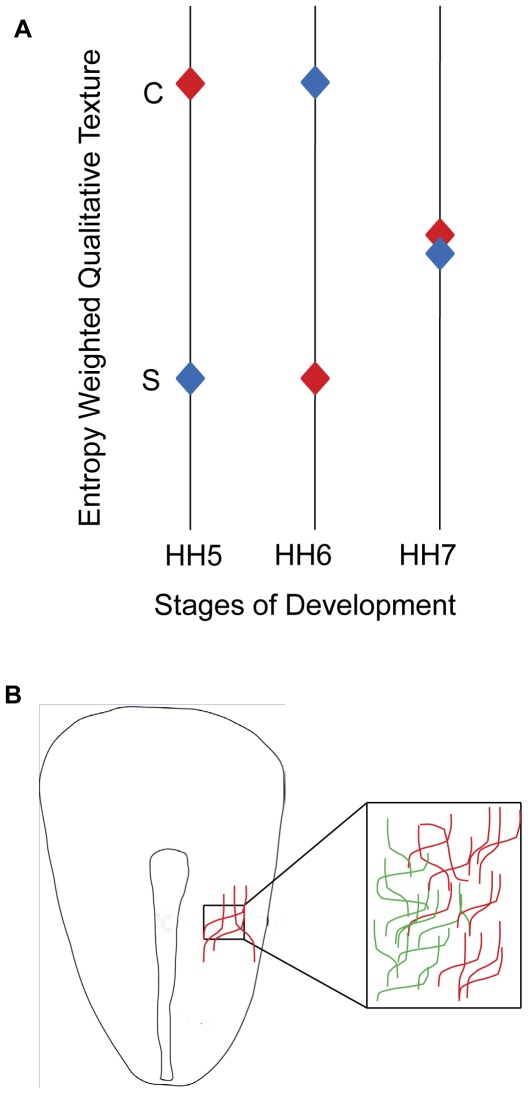
Texture timing-diagram summarizing the relative textural quality of medio-lateral fibronectin networks during avian developmental stages 5 through 7.A. Texture timing-diagram that captures the relative qualitative descriptors of texture in the ROI, weighted solely upon the scalar entropy values obtained during the stages of development (Figure 6), maps the texture as relatively “coarse/rough” and “smooth/fine.” From this qualitative perspective, the lateral fibronectin network is relatively coarse compared with the medial fibronectin network during HH stage 5 of development. However, the lateral network evolves into a relatively smooth texture during HH stage 6 of development. An absence of qualitative medio-lateral textural anisotropy in fibronectin networks during HH stage 7 is represented as overlapping diamonds that don't belong to a precise textual category. B. Embryonic ECM exhibits regional inhomogeneity of texture. The schematic demonstrates the hypothesized textural “gradient” of fibronectin (a difference in color represents a difference in the relative quality of texture) that might be relevant to mesendodermal cell motility during gastrulation. At scales coincident with the relative density of integrin (a cellular receptor for fibronectin) distribution on a mesendodermal cell, the textural anisotropy of the fibronectin network could potentially manifest as a qualitative textural “gradient” in the embryonic space, thus, influencing regional cell motility.